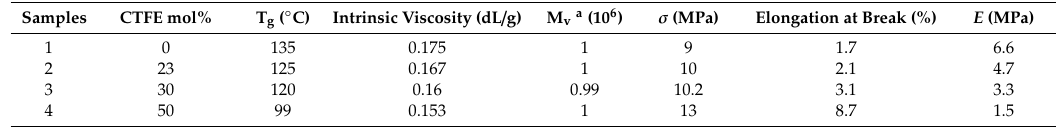
Table 10. Physical Properties of PFMMD and PFMMD- co -CTFE Copolymers.